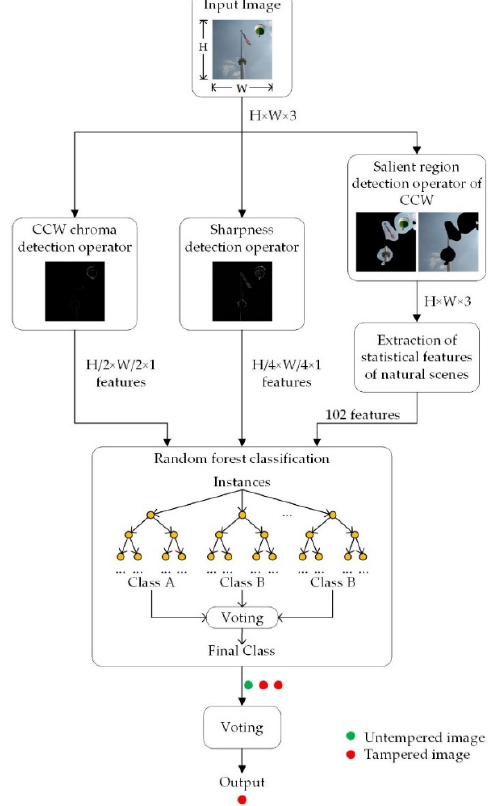
Figure 1. The overall process of the proposed detection algorithm of stitching tampering. H and W denote the height and the width of the input image, respectively.